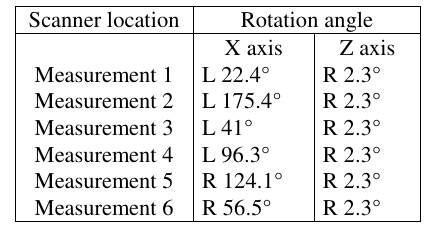
Table 1. Rotated angle of x and z axes of TLS data. Direction of rotation is shown as R (clockwise) and L